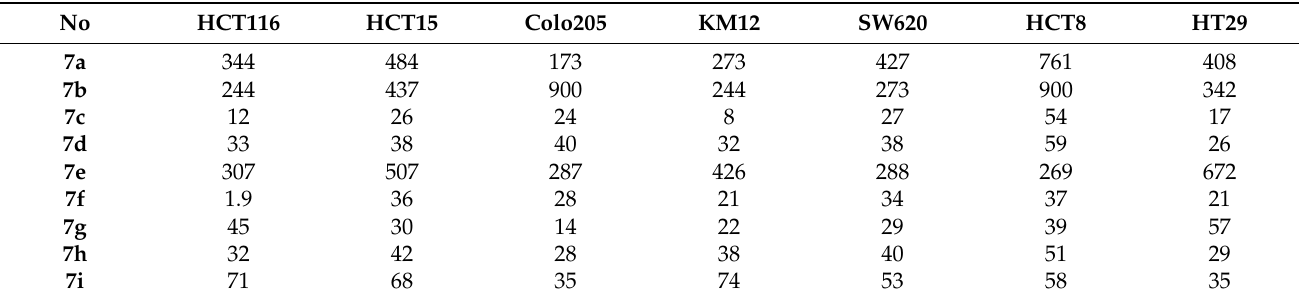
Table 2. SRB Assay of the 4-Phenyl- N -(thieno[2,3- b ]pyrazin-3-yl)piperazine-1-carboxamide Deriva- tives 7 : GI 50 values